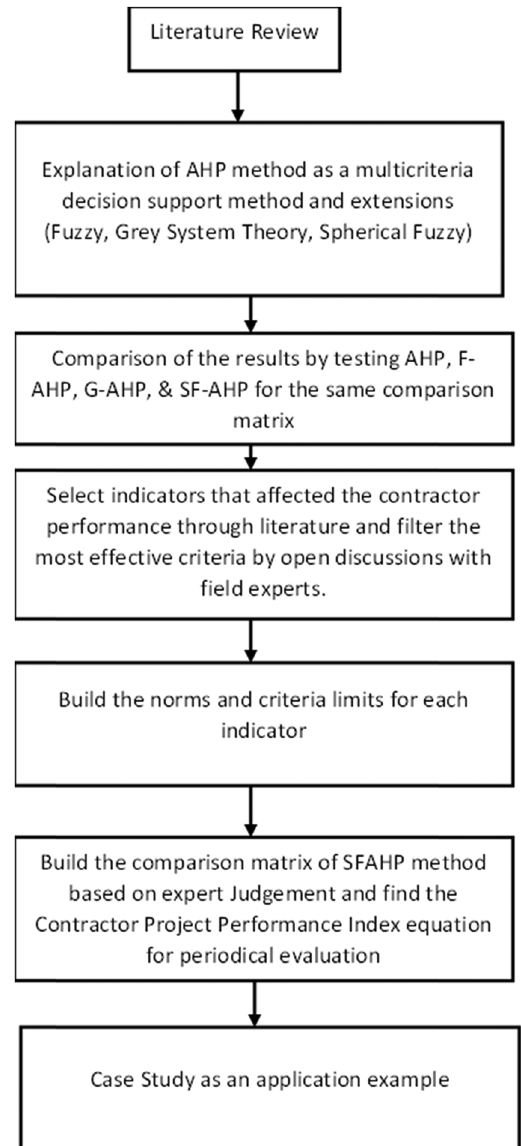
Figure 1: Research